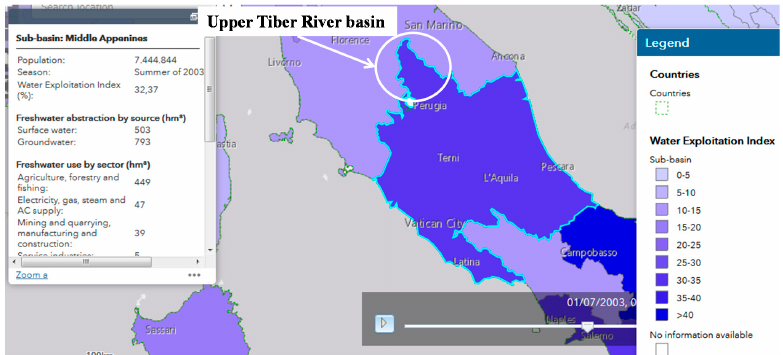
Figure 11. European Environment Agency, WEI + value in summer 2003 for the Middle Appenines District (Published 10 October 2018, last modified 28 November 2019).